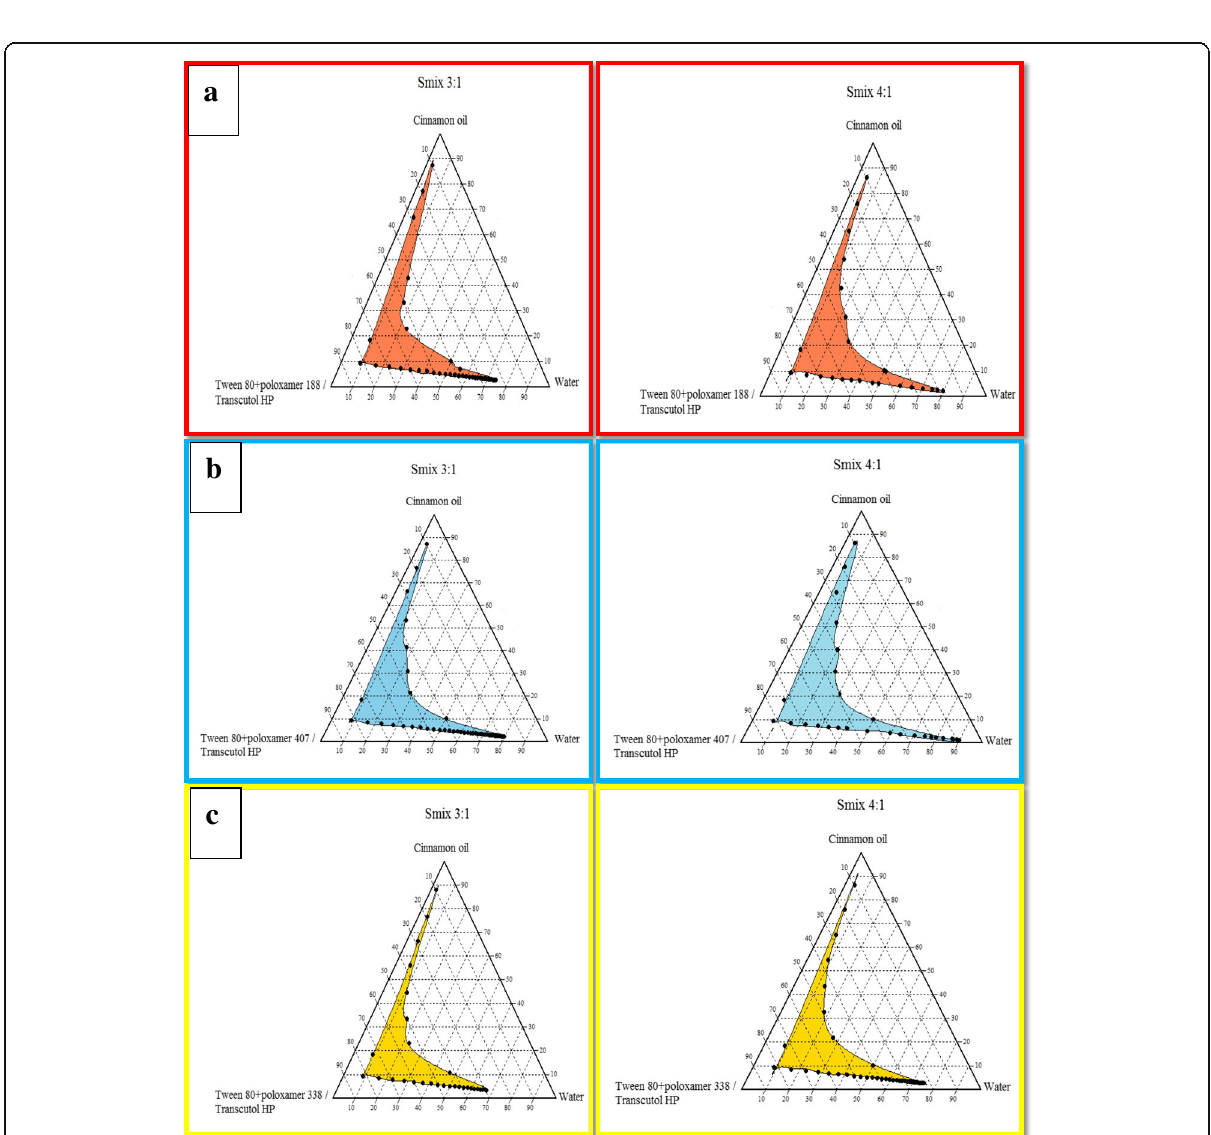
Fig. 4 Pseudo-ternary phase diagrams showing the o/w nanoemulsion ( shaded area ) regions of cinnamon oil (oil), tween 80 with different poloxamer mixture (surfactant), transcutol HP (co-surfactant) and water in 3:1 and 4:1 Smix ratios at 25 °C using: a Poloxamer 188, b Poloxamer 407 and c ) Poloxamer